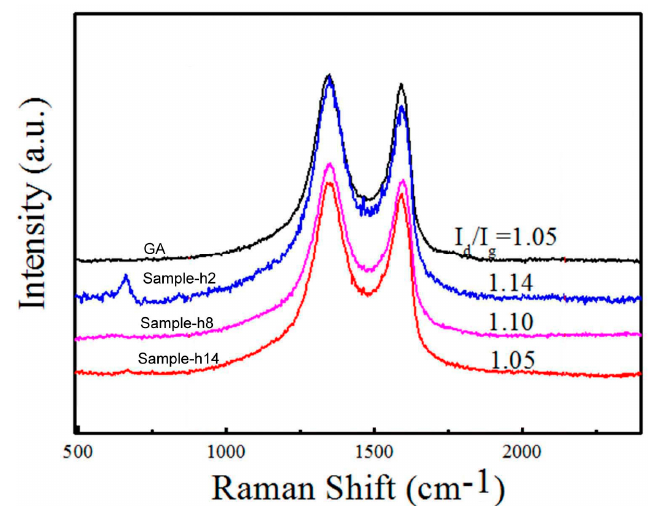
Figure 4. Raman spectra of GA and GA/Co-Fe-P samples. I d /I g is the ratio of intensities of D- and G-bands.